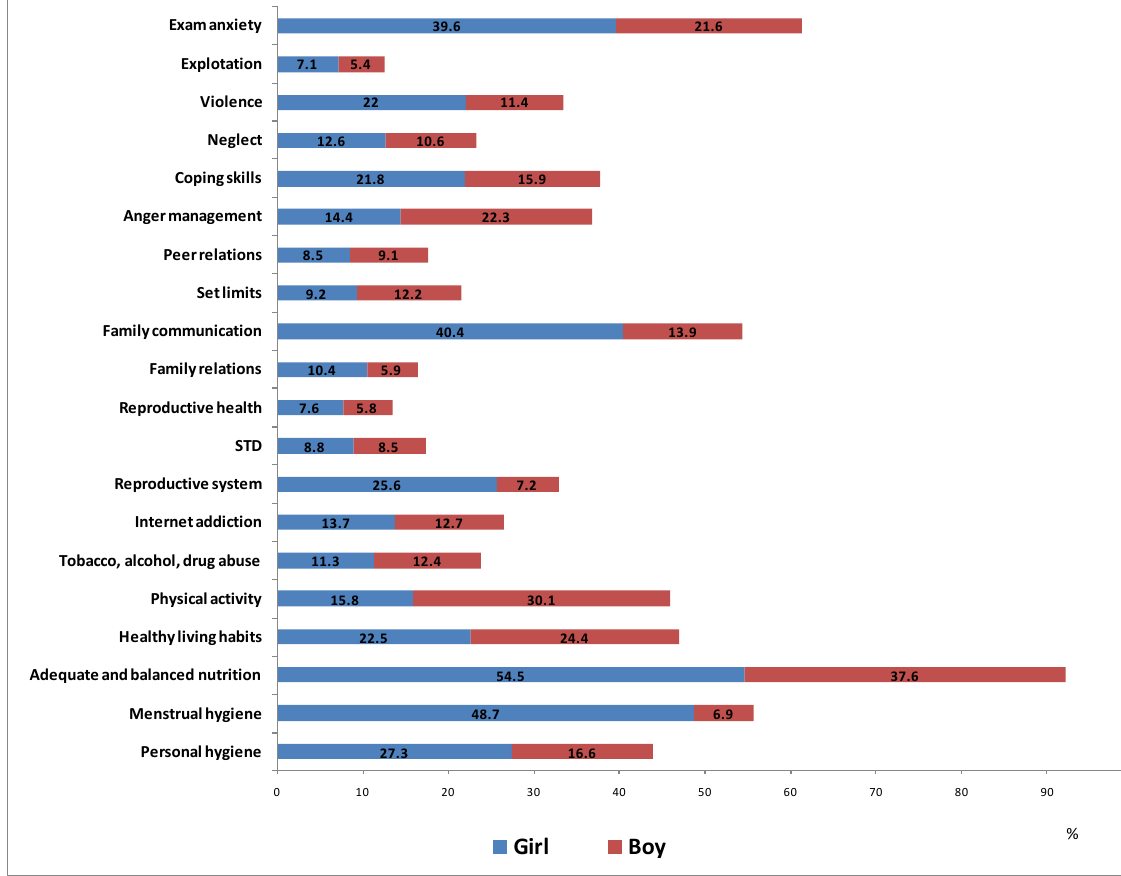
Figure 1. Topics for which students would like to receive counseling based on